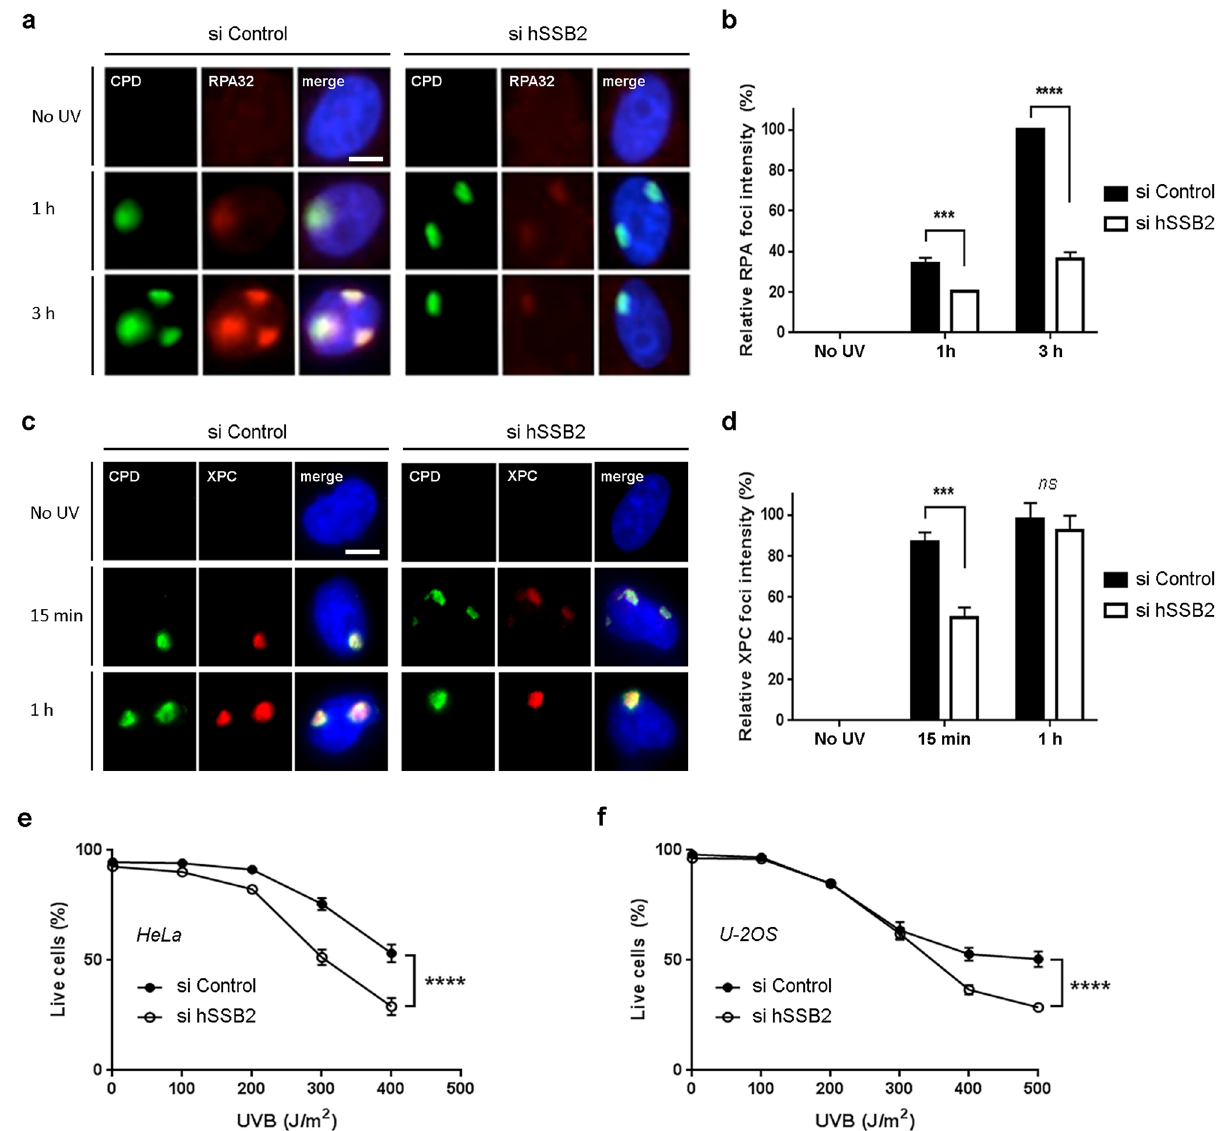
Figure 3. hSSB2 depletion delays XPC recruitment, impairs RPA recruitment to UV damage sites and increases sensitivity to UVB exposure. ( a ) Representative images of HeLa cells probed for CPD (green, left panels) and RPA32 (red, middle panels) without UV exposure or 1 h and 3 h after UVC irradiation with a 5 µm filter. Cells were irradiated 48 h after negative control (si Control) and hSSB2 (si hSSB2) siRNAs transfection with UVC covered with 5 µm filter. DNA is stained with DAPI (blue, right panels). Average RPA32 fluorescent staining intensity at the CPD sites (± sem, n = 3) has been reported in graph ( b ). ( c ) Representative images of HeLa cells probed for CPD (green, left panels) and XPC (red, middle panels) without UV exposure or 15 min and 1 h after UVC irradiation. DNA is stained with DAPI (blue, right panels). Average XPC fluorescent staining intensity at the CPD sites (± sem) has been reported in graph ( d ). Scale bar represents 5 µm. ( e , f ) Measure of the average live cells (± sem, n = 3) 48 h after UVB exposure of HeLa cells transfected with negative control (si Control) or hSSB2 (si hSSB2) siRNAs ( e ) and U-2OS cells ( f ). Analysis was carried out with the Cytell imaging system 20 min after Hoechst and Propidium Iodide staining (****P-value < 0.0001 in a Student